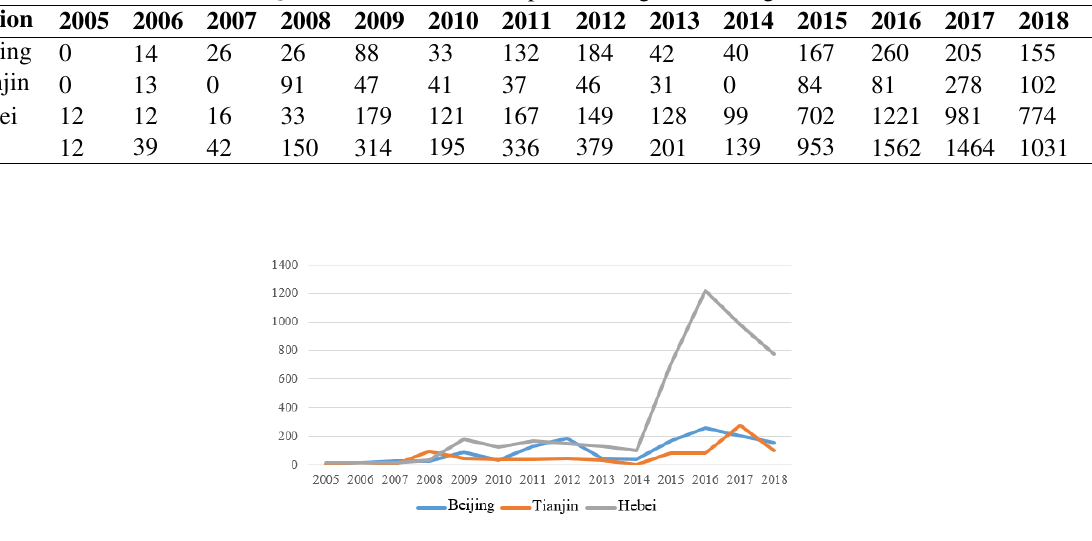
Fig. 1 The quantitative results of the policies of government guidance funds